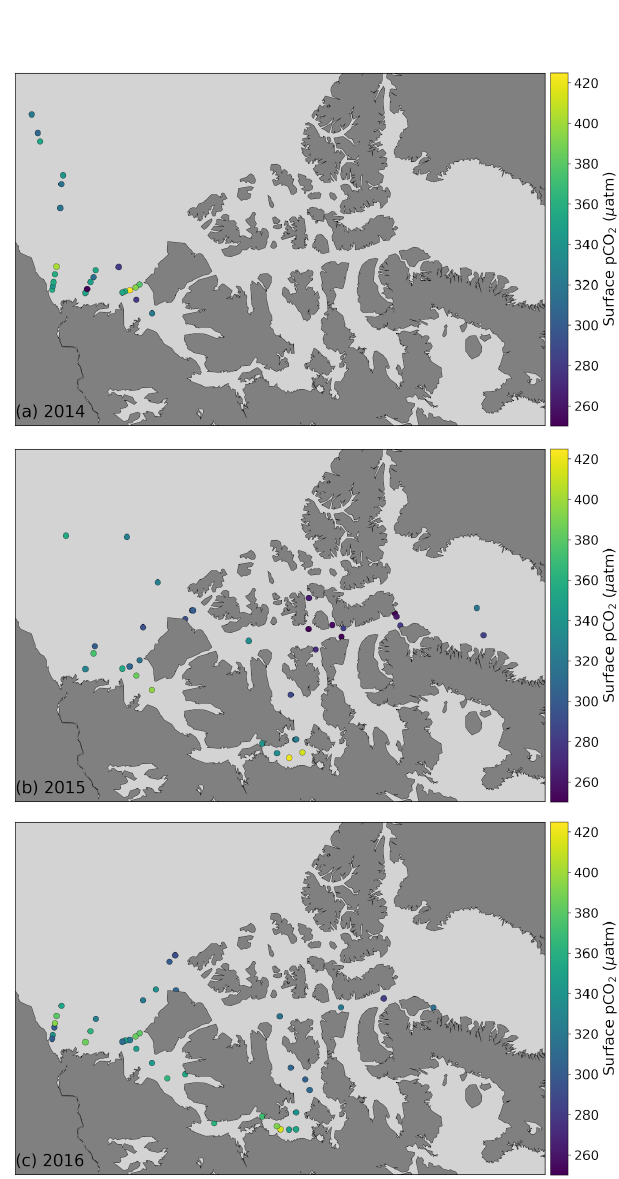
Figure 4. Surface water ( < 5m) p CO 2 in 2014 (a) , 2015 (b) and 2016 (c) in the study